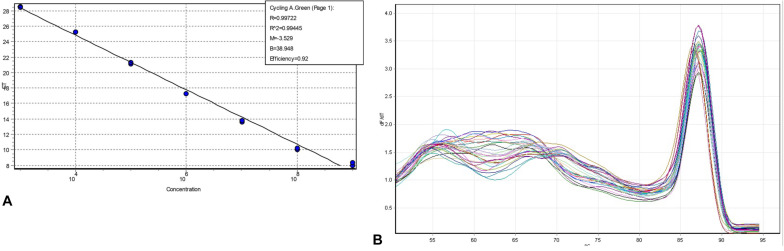
Amplification efficiency and melting curve analyses of invA determined in 10-fold serial dilutions of DNA. (A) PCR performed on Salmonella DNA extracted from a pure culture with 1 × 109 CFU/mL. (B) Melting curve of invA (605 bp) in DNA obtained from 10-fold serially diluted (108 to 101 CFU/g) Salmonella spiked soil samples.